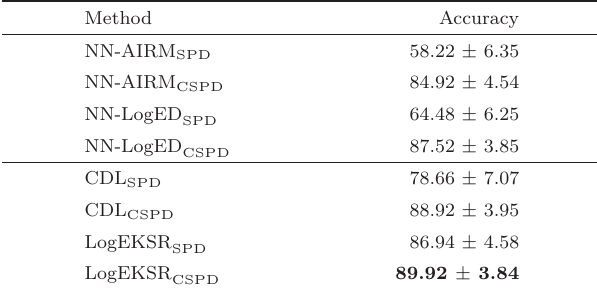
Table 1 Recognition rates with standard deviations, ETH-80 dataset